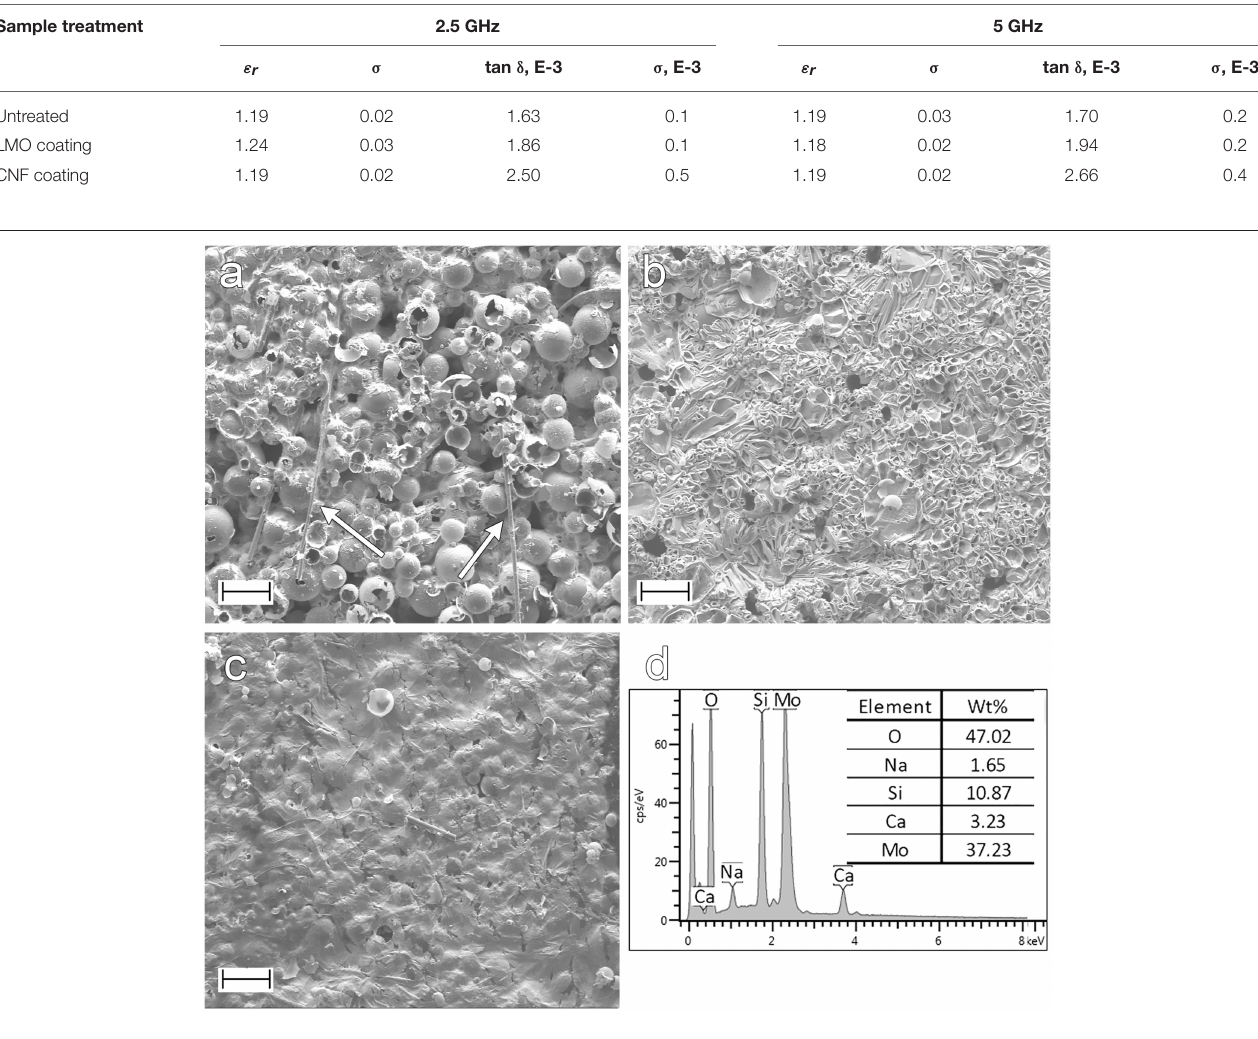
FIGURE 2 | (a) Uncoated sample. The surface consisted of LMO- bound HGMS showing porosity and some quartz fibers (white arrows). (b) LMO-coating reduced the surface porosity and submerged fibers. The LMO was observed to form hexagonal patterns on the sample surface. (c) CNF coated sample showed the smoothest surface with only a minor amount of porosity visible. All scale bars 100 µ m. (d) EDS analysis of uncoated sample surface showing molybdate and oxygen from the LMO and the other elements from the